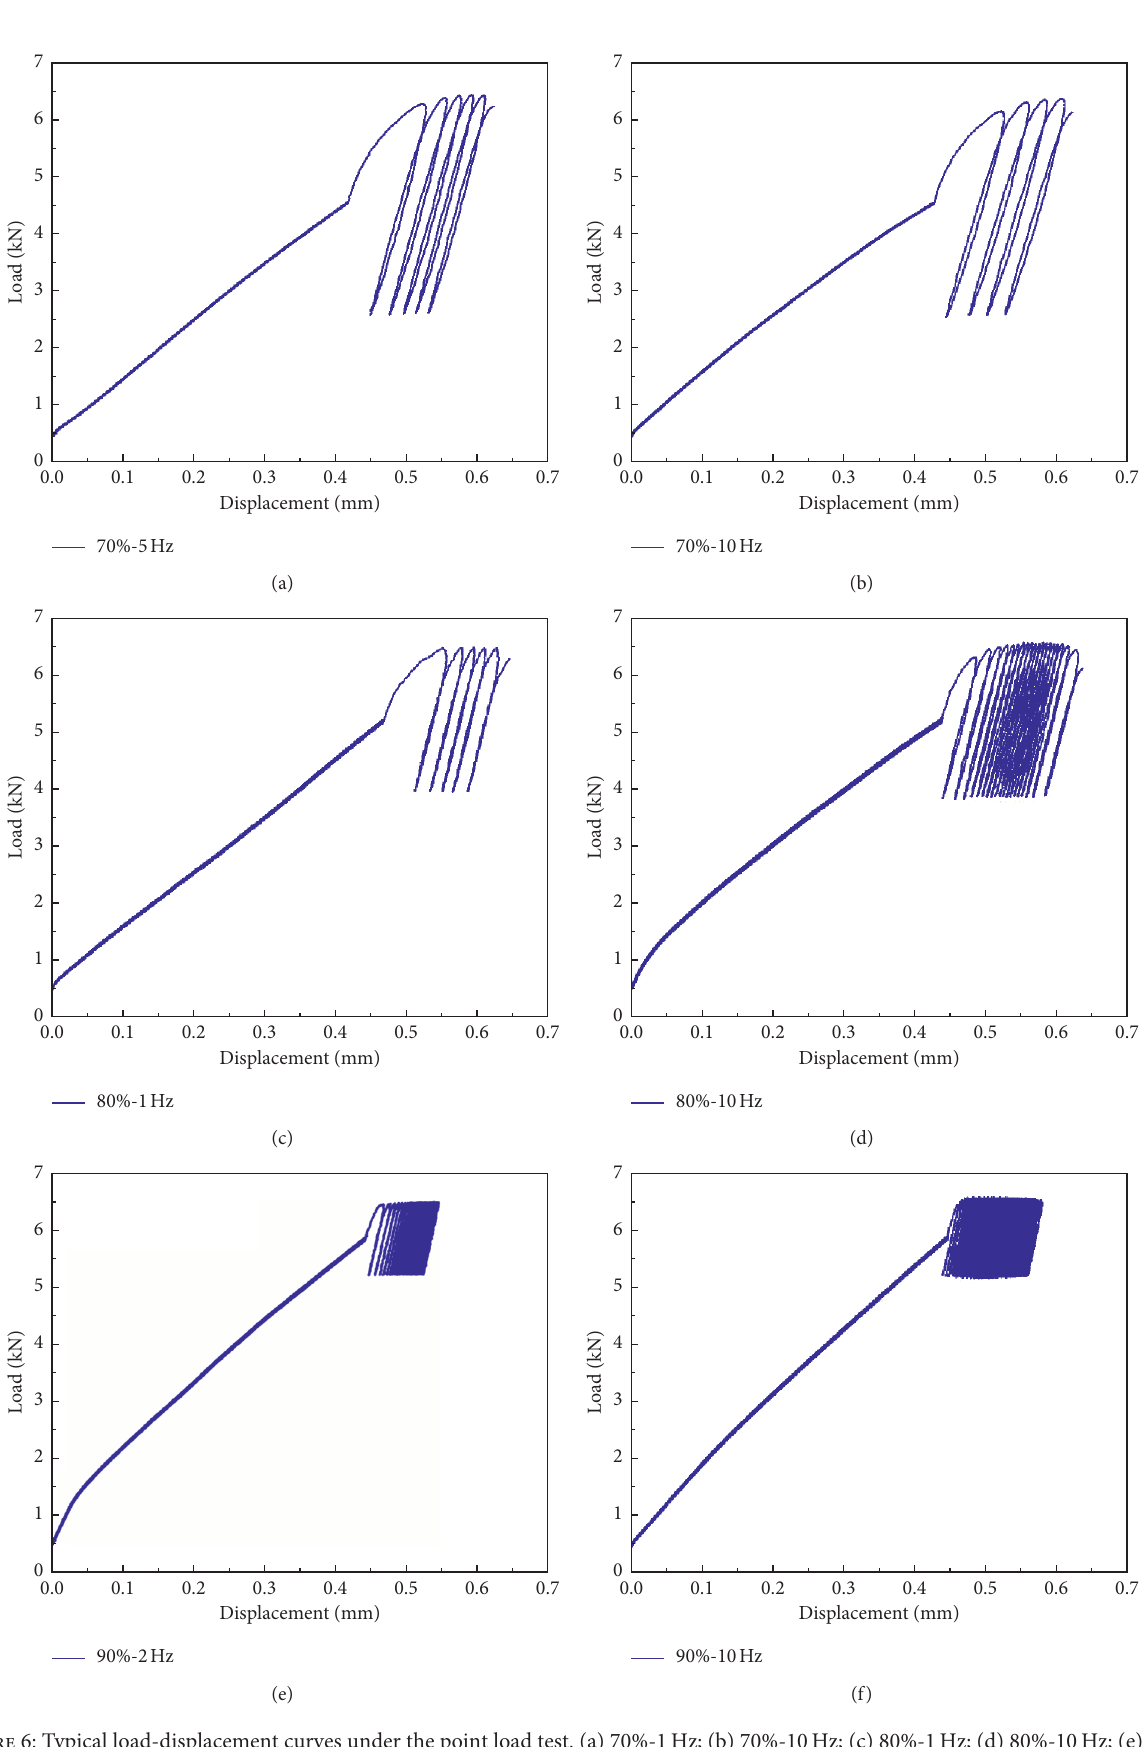
Figure 6: Typical load-displacement curves under the point load test. (a) 70%-1Hz; (b) 70%-10 Hz; (c) 80%-1Hz; (d) 80%-10 Hz; (e) 90%- 2Hz; (f) 90%-10